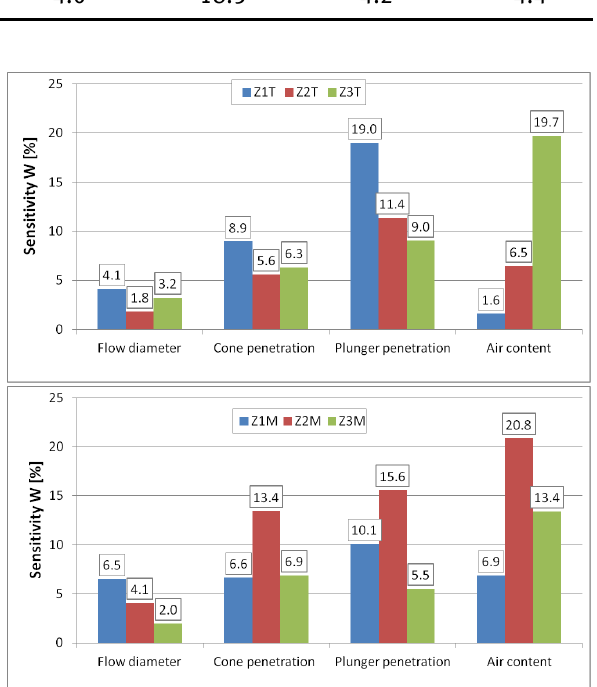
Figure 1: The sensitivity of the properties of plasters (top) and mor- tars (bottom) to changes in temperature.